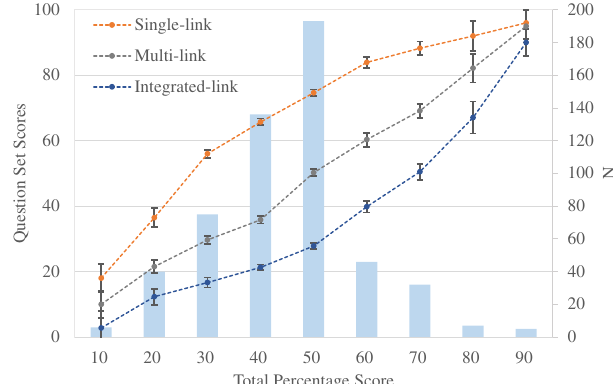
FIG. 3. Plot of question set subscores across total scores (with error bars denoting standard error) for all pre- and post-test data combined. Frequency of total score distribution is shown as a bar chart in the background, with absolute count of students falling into each range shown on the right axis.